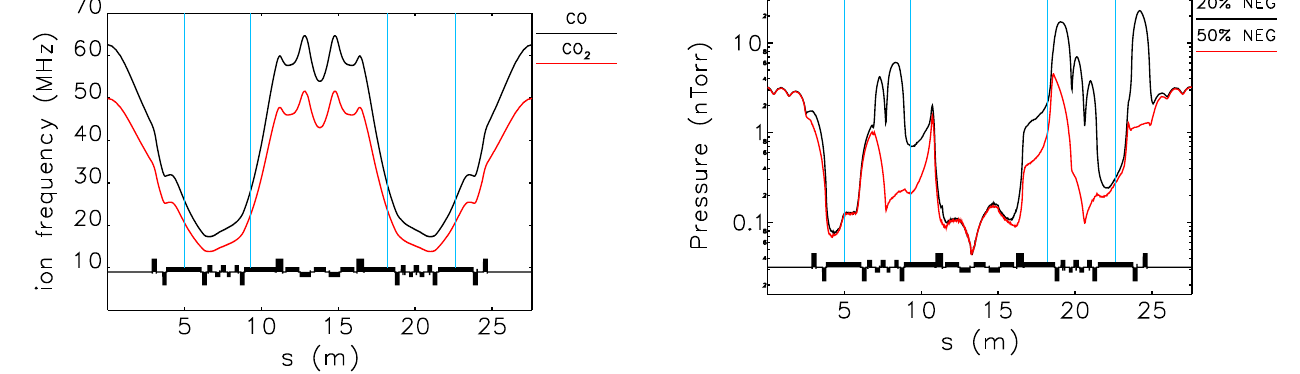
FIG. 3. Ion frequencies for one sector of the APS-U lattice, 324 bunches, round beams, 200 mA. The vertical lines indicate the regions where CO 2 ions are trapped (the CO trapping regions are slightly narrower).